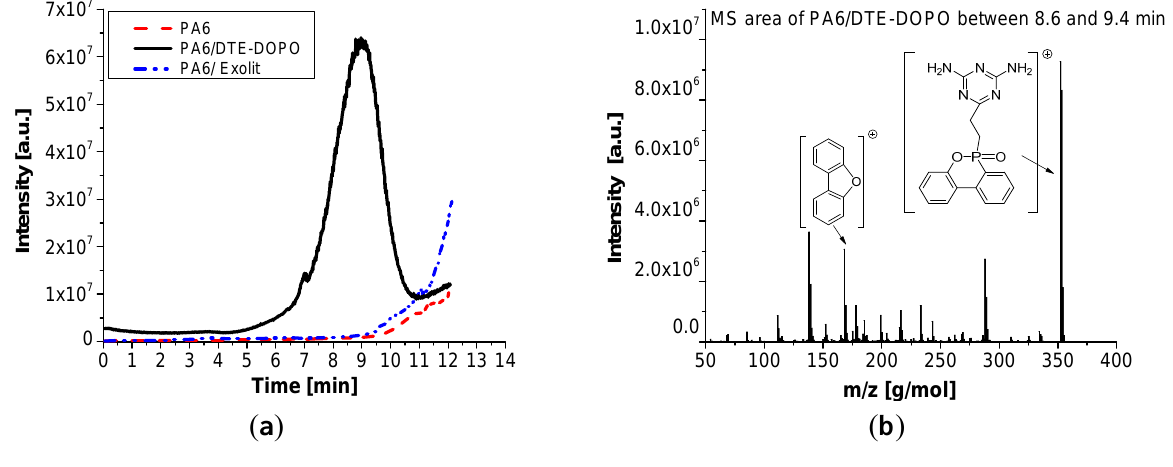
Figure 7. DIP-MS data of PA6 formulations: total ion chromatogram ( a ) and the corresponding mass profile between 8.6 and 9.4 min ( b ).